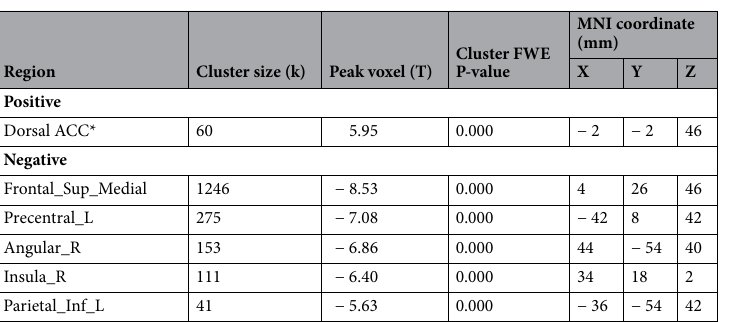
Region Cluster size (k) Peak voxel (T)